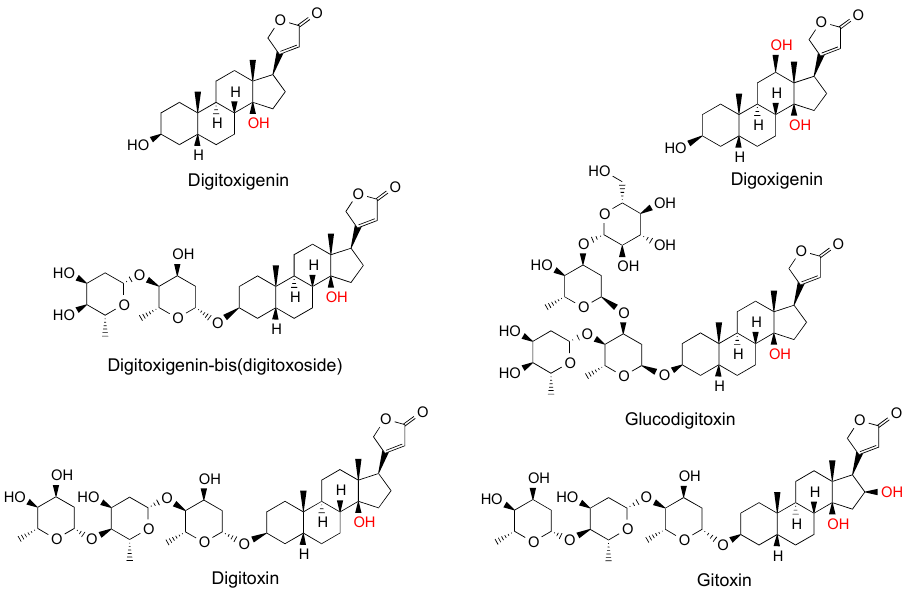
Figure 11. Structure of cardenolides isolated from diverse Digitalis